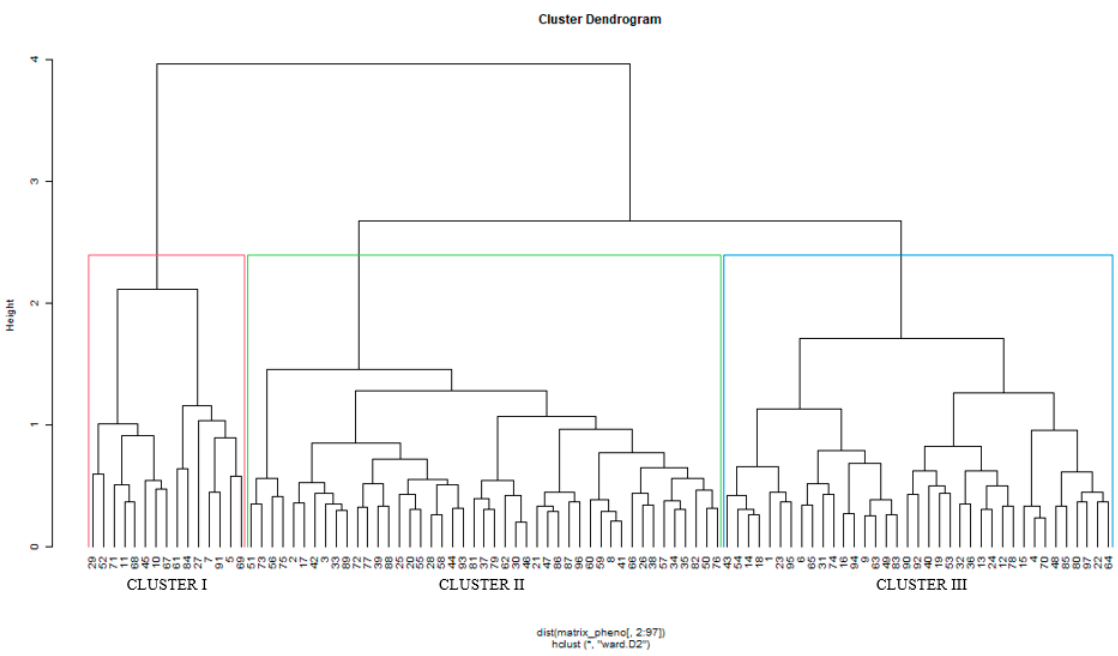
Figure 1. Hierarchical clustering of 97 wheat genotypes based on phenotypic traits measured under non-stressed conditions. Clusters are separated by color lines.